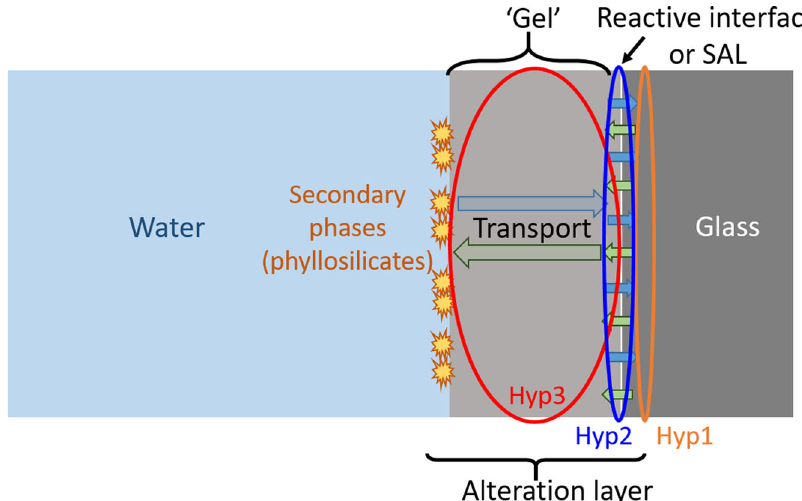
Fig. 5 Schematic of glass alteration layer and three hypotheses detailed in text. The fi rst hypothesis concerns the glass because it involves an initial water penetration. Then, the interdiffusion process induces the transformation of the glass in what is called the ‘ reactive interface ’ .